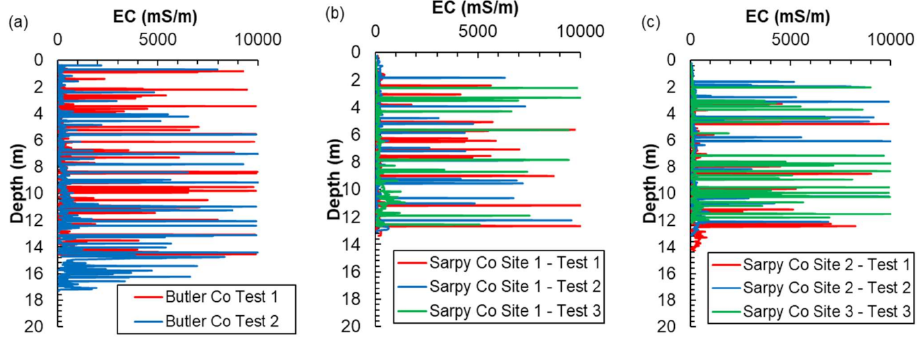
Figure 9. Electrical conductivity profile: ( a ) Butler County, ( b ) Sarpy County Site 1, and ( c ) Sarpy County site 2.